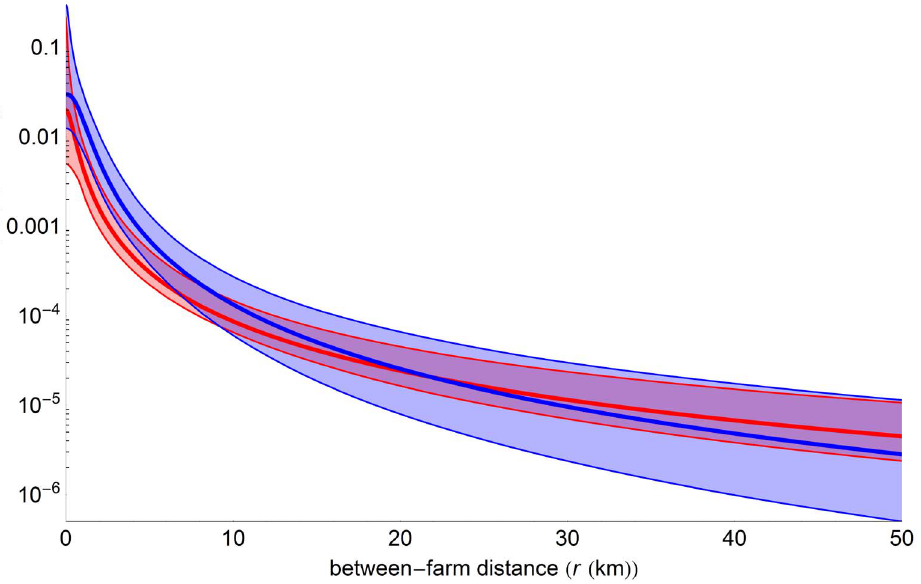
Figure 4. Transmission kernel comparison. Comparison between the estimated transmission kernels for period 1 (red) and period 2 (blue). Thick lines: Maximum-Likelihood estimate of the transmission kernel; thin lines: confidence bounds calculated as explained in [3].